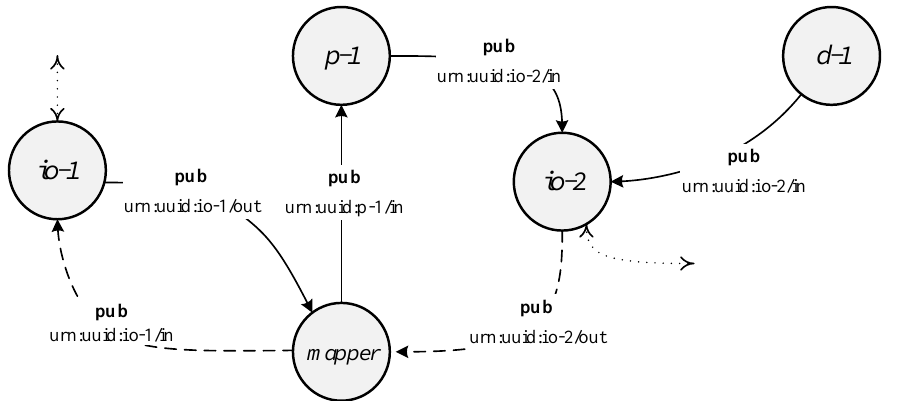
Figure 4. A directed graph constructed using the different types of adapters. Adapter io-1 is an I/O adapter. Adapter p-1 is a processing adapter and adapter io-2 is another I/O adapter. The mapper adapter passes the messages along the vertices. Adapter d-1 communicates directly with io-2